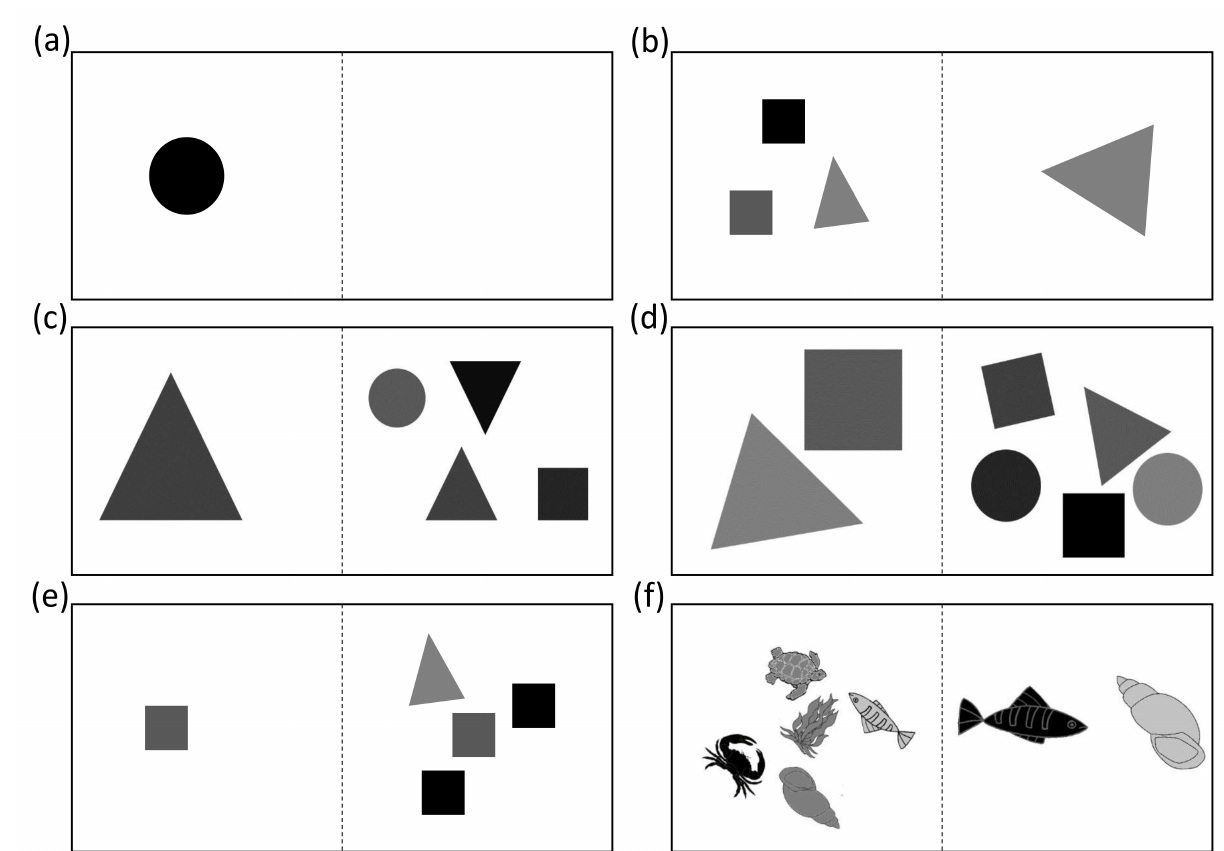
Figure 2. Example slides for the numerical discrimination training and transfer tests. ( a ) Pretraining ( b ) 3 vs. 1 Training ( c ) 4 vs. 1 Training ( d ) 5 vs. 2 Training ( e ) Transfer test with same-sized stimuli ( f ) Transfer test with non-geometrical stimuli. Except for the Pretraining, all slides shown are just representative cards (out of at least 40 for each pair) and were controlled for continuous variables. The dotted line indicates the area in which a divider separated the left from the right side and was not present on the actual stimuli